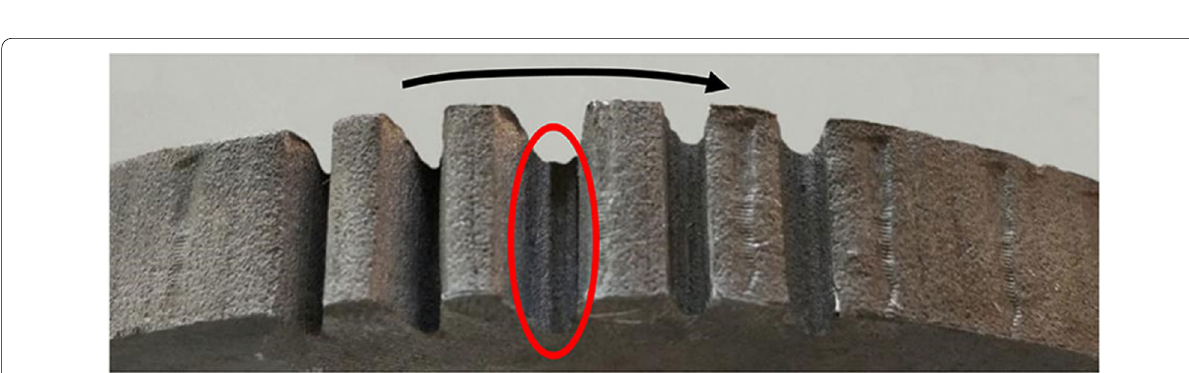
Figure 17 The verification result of fold in the third pass of Scheme 2-4 caused by unreasonable preforming feed